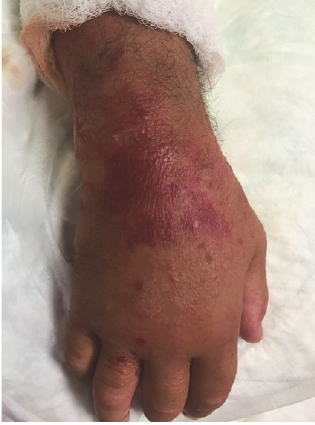
Figure 2: Right hand on the day of presentation.